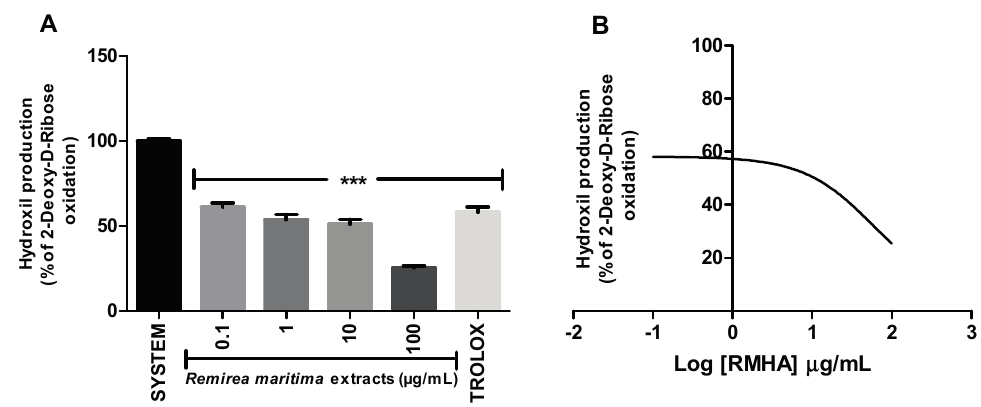
Figure 2. ( A ) Hydroxyl radical-scavenging activity quantified using the oxidative in vitro degradation of 2-deoxyribose; ( B ) Log IC 50 of RMHA hydroxyl scavenging activity. TROLOX ® (75 µg/mL) was used as standard antioxidant. Bars represent mean ± SEM. *** p < 0.001 (1-way ANOVA followed by Tukey’s multiple comparison post hoc test). 2.4. Ferric Reducing Antioxidant Power (FRAP) and Fe 2+ Chelation Assay